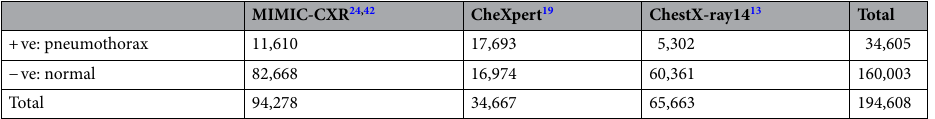
MIMIC-CXR 24,42